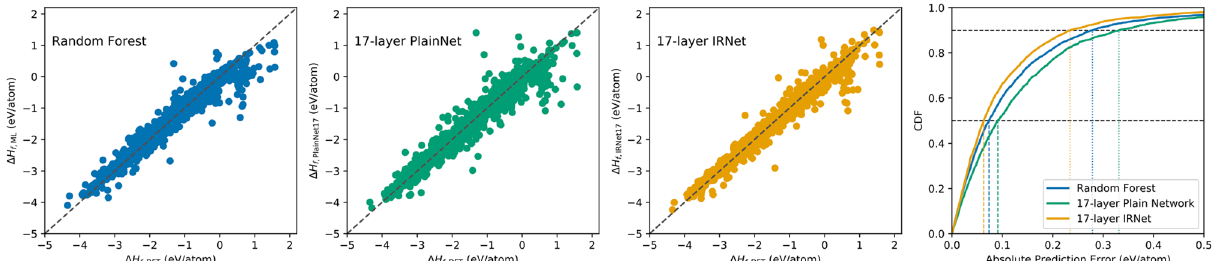
Figure 3. Prediction error analysis for prediction formation enthalpy in JARVIS dataset using different models. We use the 145 physical attributes derived from material composition as the model inputs. We benchmark against plain network and several traditional ML models such as Linear Regression, SGDRegression, ElasticNet, AdaBoost, Ridge, RBFSVM, DecisionTree, ExtraTrees, Bagging and Random Forest, with exhaustive grid search for hyperparameters; Random Forest performed best among traditional ML algorithms. We use the prediction errors on the hold-out test set using a random 9:1 train:test split. The first three subplots represent the prediction errors using three models: Random Forest, 17-layer Plain Network and 17-layer IRNet; the last subplot contains the cumulative distribution function (CDF) of the prediction errors using the three